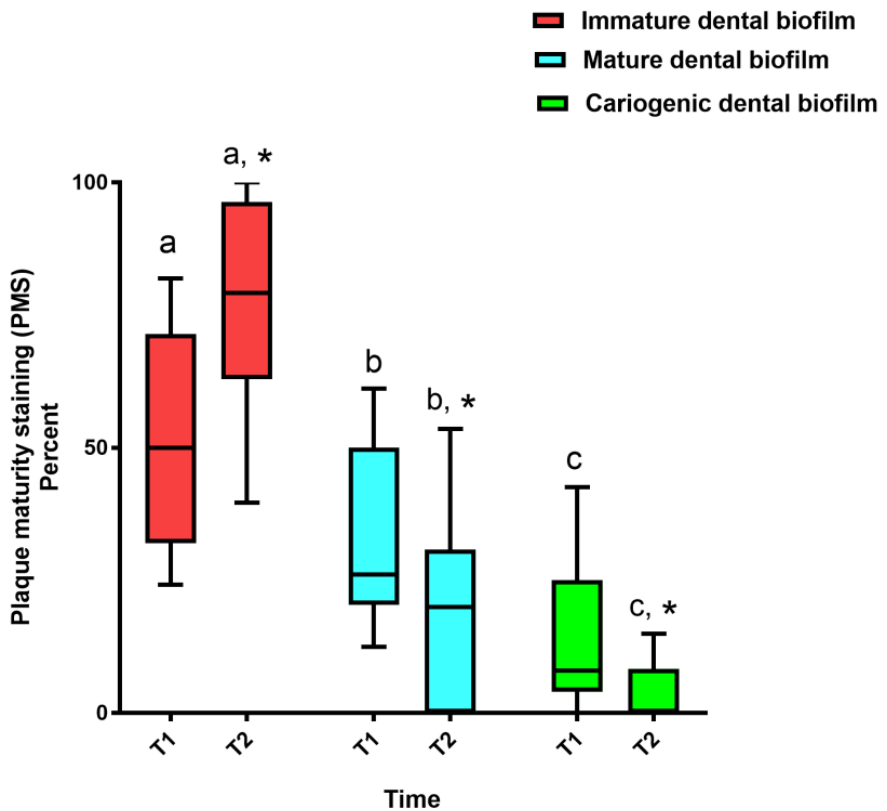
Figure 3. Frequency distribution of plaque maturity staining (PMS) in the SSL group. Dental biofilm staining was performed before SSL tying (T1) and at the 4-week follow-up (T2). The intervention was the combined horizontal–Charters–modified Bass tooth brushing technique. The boxes represent the interquartile range, and the horizontal bars within the boxes represent the median. The lower and upper ends of the vertical lines represent the 10th and 90th percentiles, respectively. The asterisks denote a significant difference in % PMS between T1 and T2 (Wilcoxon signed-rank test, p < 0.05). Different superscript letters indicate significant differences between the PMS at each time point (Kruskal–Wallis with Dunn–Bonferroni post hoc test, p <